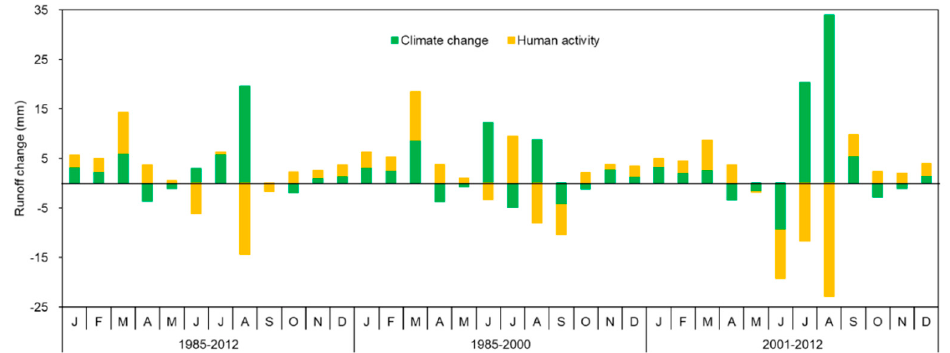
Figure 9. Runoff change (mm) induced by climate variability and human activity on the monthly scale over three different periods (1985–2012, 1985–2000, and 2001–2012) for the Qingliu River basin, East China. J–D are the abbreviations of January to